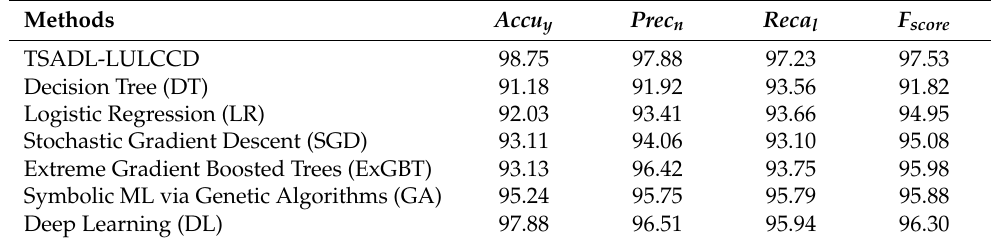
Table 5. Comparative analysis of TSADL-LULCCD approach with other approaches.